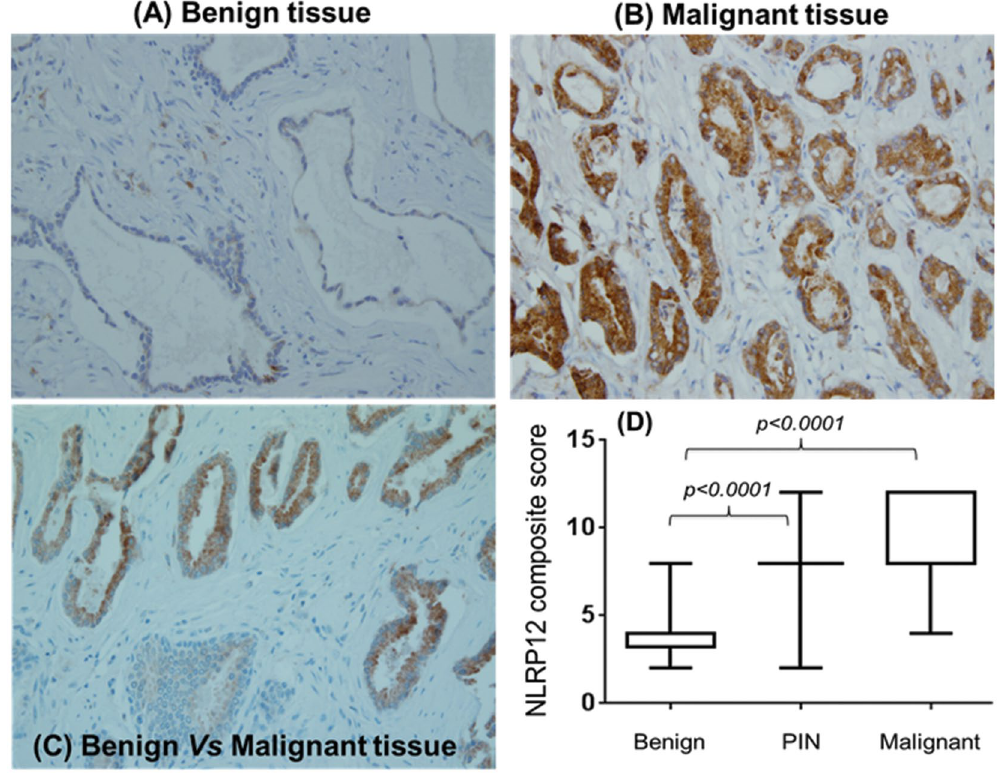
Figure 4. Representative immuno-stained slides for NLRP12 protein expression in human prostate archival tissue specimens (n = 40). ( A ) benign tissue, ( B ) malignant tissue; ( C ) immunostaining distribution between benign and malignant tissue in the matched sample; and ( D ) overall composite score in BPH, PIN, and malignant tissues with a significant increase (p < 0.0001) of NRLP12 protein in malignant and PIN as compared to benign tissue. The values are expressed as the standard error of the mean (m ± SE).